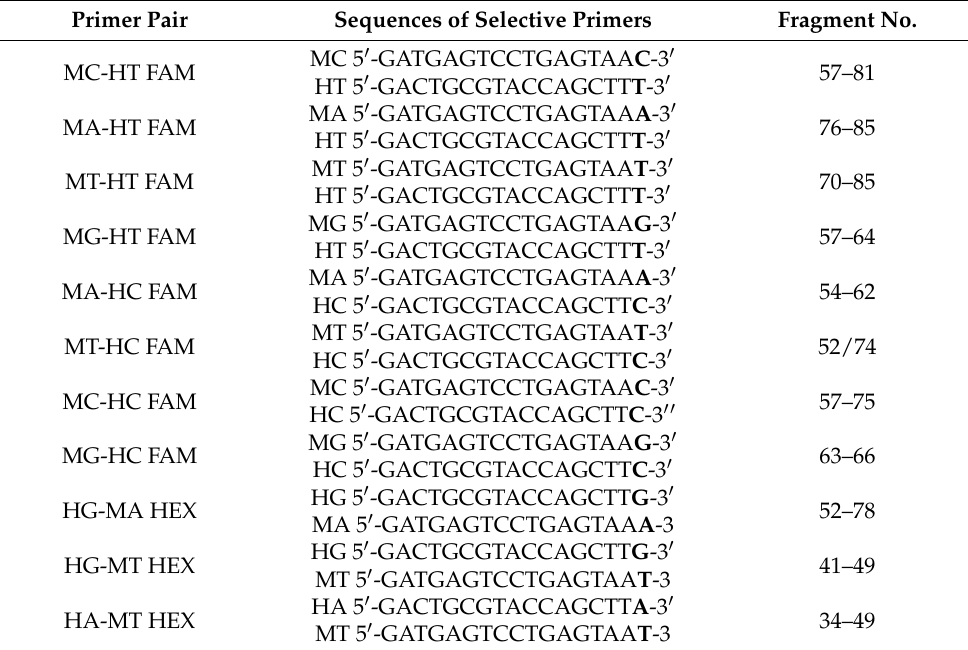
Table 3. The average number of fragments obtained from eleven selective primer combinations and sequences to detect AFLPs among O. oeni strains isolated from Grenache wines. Bold type indicates the additional bases used for the selective primer. Primer Pair Sequences of Selective Primers Fragment